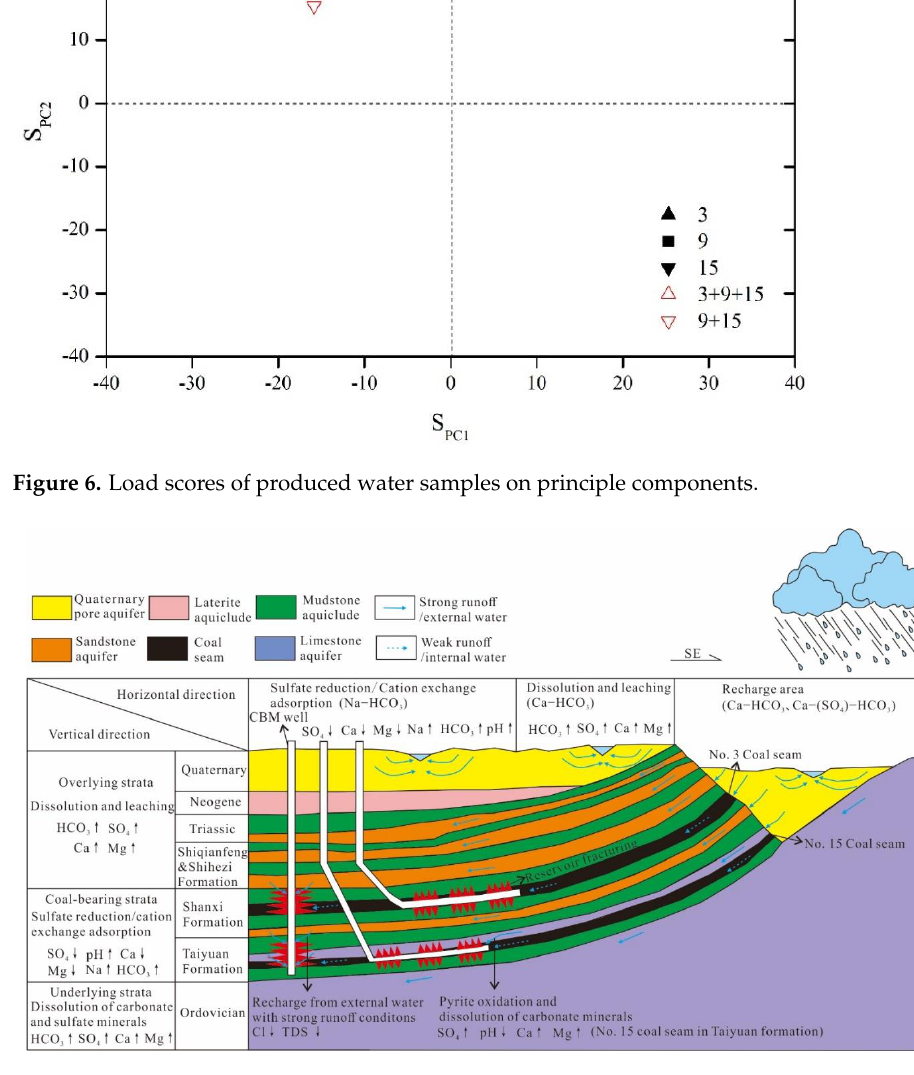
Figure 7. Model of the geochemical formation of produced